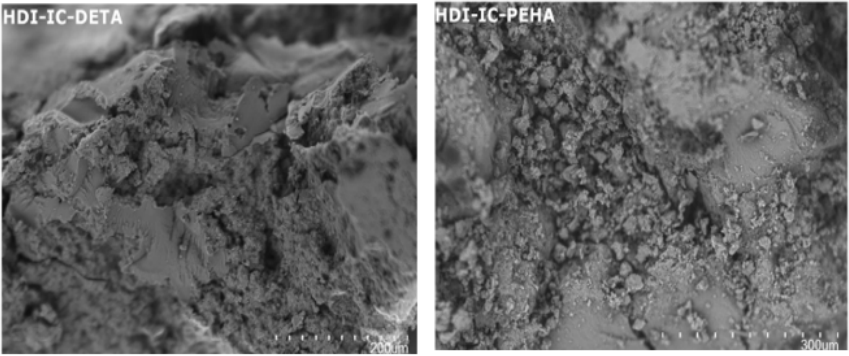
Figure 1. SEM images of HDI-IC-DETA and HDI-IC-PEHA. Adapted with permission from [96]